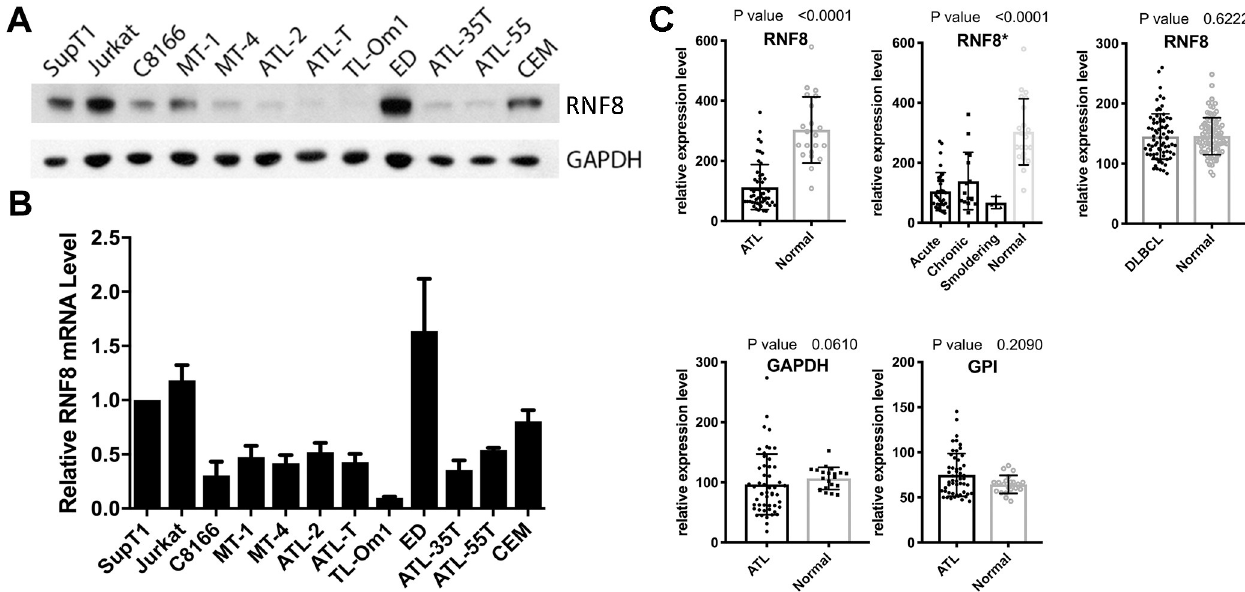
Fig 5. Frequent down-regulation of RNF8 expression in ATL cells. (A) Immunoblots of RNF8 and GAPDH in ATL, HTLV-1-transformed, and HTLV- 1-negative T cell lines. ATL: MT-1, ATL-2, ATL-T, TL-Om1, ED, ATL-35T, & ATL-55; HTLV-1-transformed: C8166 & MT-4; and HTLV-1-negative: SupT1, Jurkat, & CEM. Antibodies used are as indicated, with GAPDH as a control for sample loading. (B) qRT-PCR analysis of RNF8 mRNA in ATL, HTLV-1-transformed, and HTLV-1-negative T cell lines. qRT-PCR of RNF8 and β -actin mRNAs was carried out for the cell lines listed in (A) and the ratio of the two calculated, and then normalized against that of the control SupT1 cells, and plotted. (C) RNF8 mRNA expression in the peripheral blood mononuclear cells (PBMCs) of ATL patients and CD4+ T cells of healthy volunteers. RNF8, glyceraldehyde-3-phosphate dehydrogenase (GAPDH) and glucose 6-phosphate isomerase (GPI) mRNA expression values of 52 ATL patients (ATL) and 21 healthy volunteers (Normal) were obtained from the NCBI ATL microarray data set (GSE33615) originally generated by Nakano et al [34, 42] using the CD4+ cells of healthy volunteers and the PBMCs of ATL patients (consisting of mostly ATL cells, Note: Most ATL cells contain a single copy of proviral DNA per cell. The PVLs of acute, chronic, and smoldering ATL were previously determined to be around 85.7, 76.4, and 23.6 per 100 PBMCs respectively [43]. Thus, ATL cells represent approximately 85.7%, 76.4%, and 23.6% of the PMBC populations in acute chronic, and smoldering ATL patients.) The data were derived using the Agilent-04850 whole human genome microarray platform. The expression values of RNF8, and GAPDH and GPI controls in each ATL patient (ATL) and healthy volunteer (Normal) were normalized to that of the cognate β -actin. Mann-Whitney test was performed to compare the normalized expression values using the GraphPad PRISM (8.0c) software. The RNF8 mRNA levels in all ATL patients vs healthy donors were shown in the upper left panel. The RNF8 expression data were further divided into acute, chronic and smoldering types and compared with those of healthy volunteers (Normal) using the Brown-Forsythe and Welch ANOVA tests (upper middle panel). As a control, a similar analysis of the relative RNF8 mRNA levels in the peripheral blood cells of 76 DLBCL patients versus 87 healthy donors (GSE83632) is shown in the upper right panel.